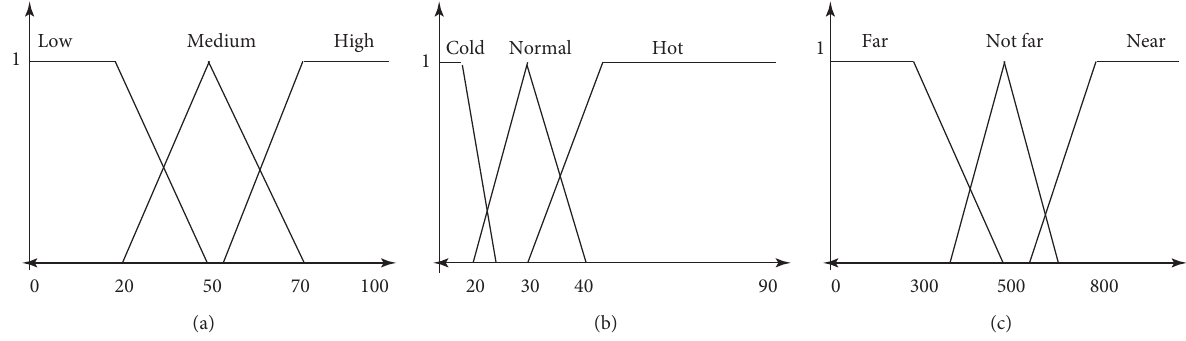
Figure 4: Fuzzy membership sets. (a) Smoke density. (b) Temperature. (c)